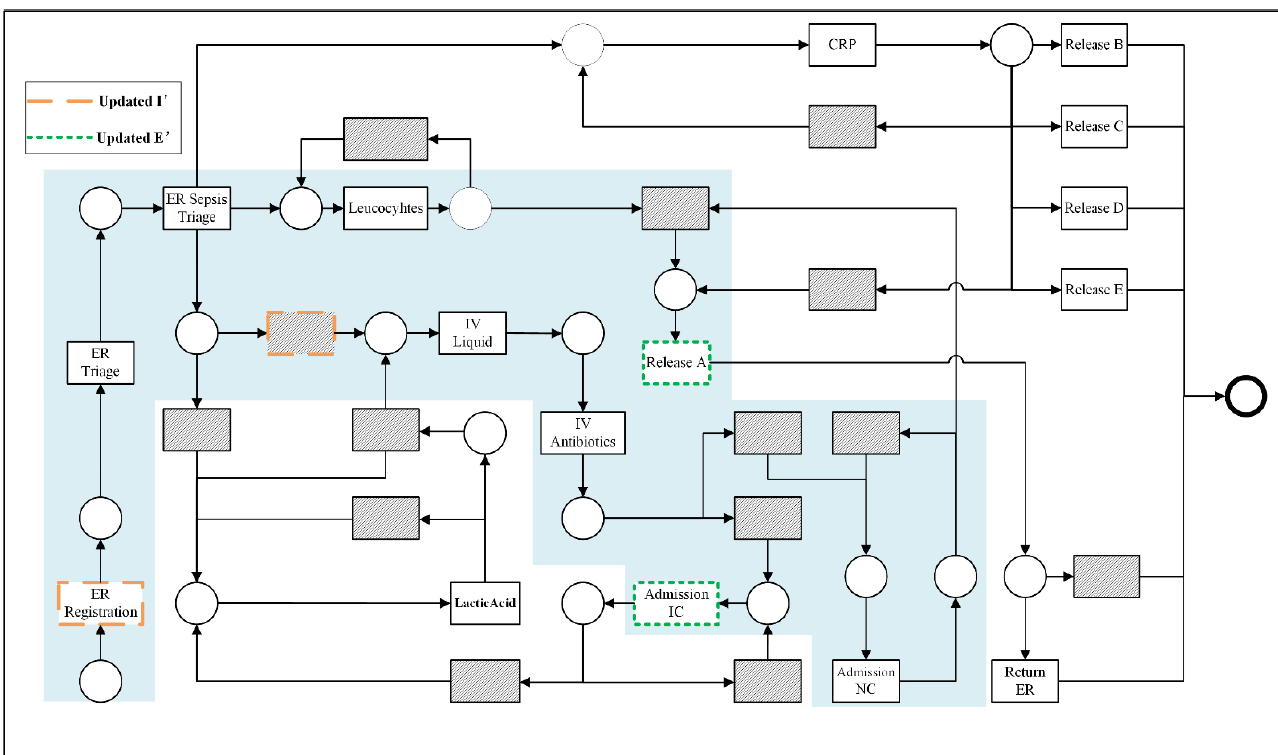
Figure 8. Crucial region of the example candidate set CS (marked by the light blue dashed box).